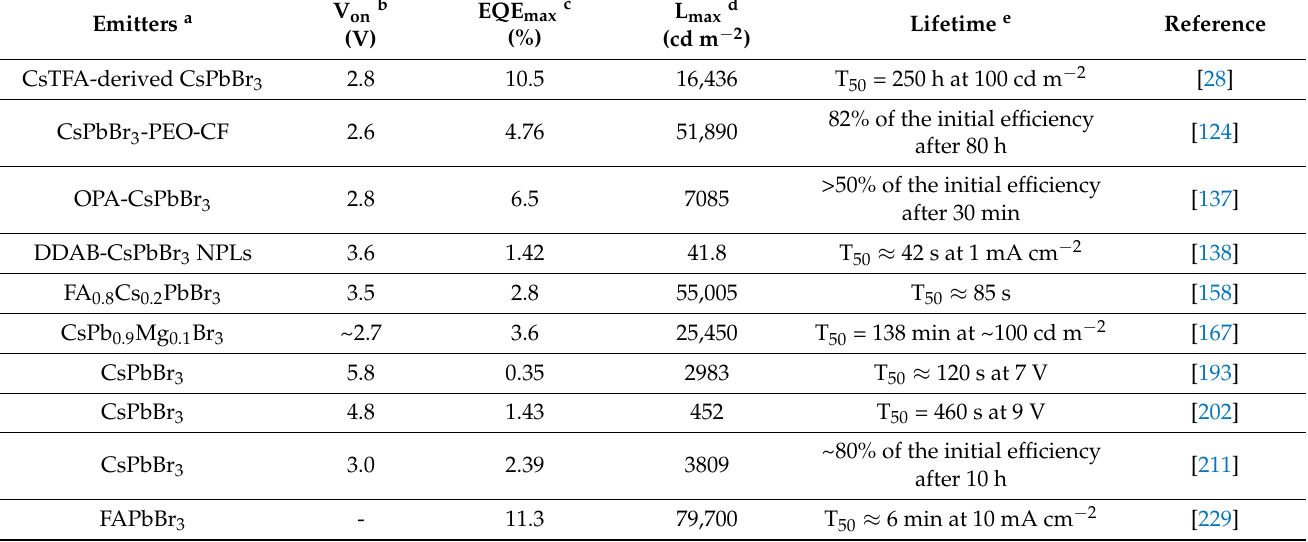
Table 1. Summarized performances for representative PeLEDs possessing improved